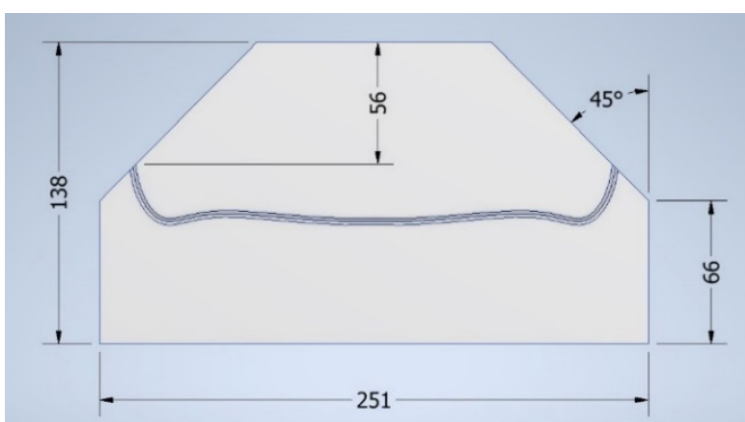
Figure 29. The model no. 5. Constraints were imposed by blocking the displacements of the curve points. A normal pressure uniformly distributed on the edge of the plate equal to 25 MPa was applied for all the proposed variants. The pressure value was determined by